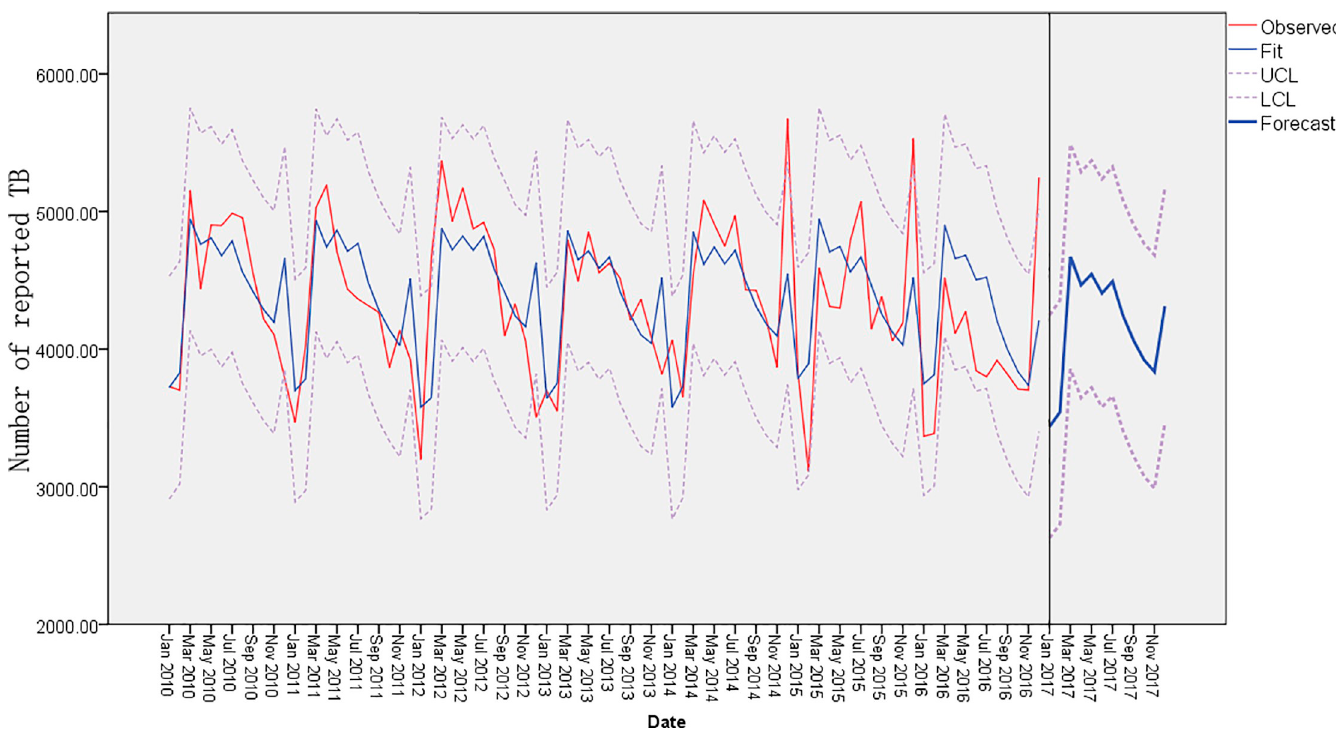
Fig 1. Monthly time series and forecast curve of TB notification in Guangxi, 2010–2017.